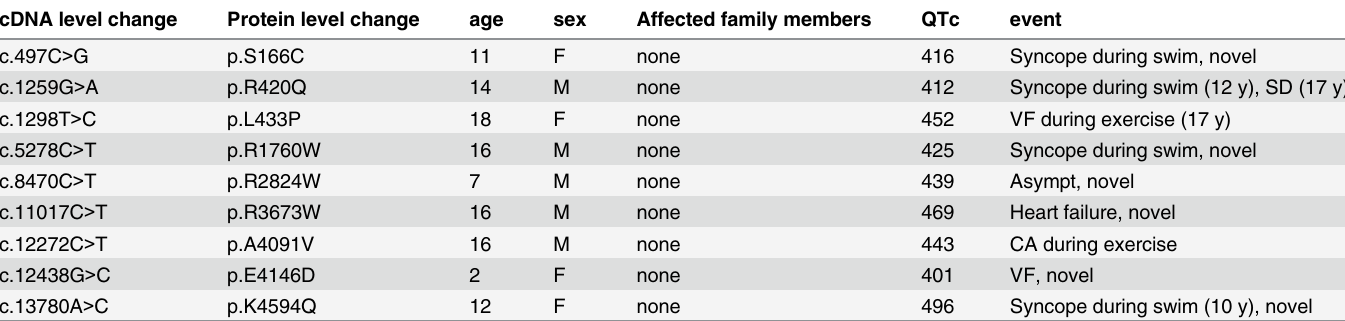
Table 6. Clinical background of patients with long-QT interval and RYR2 mutation cDNA level